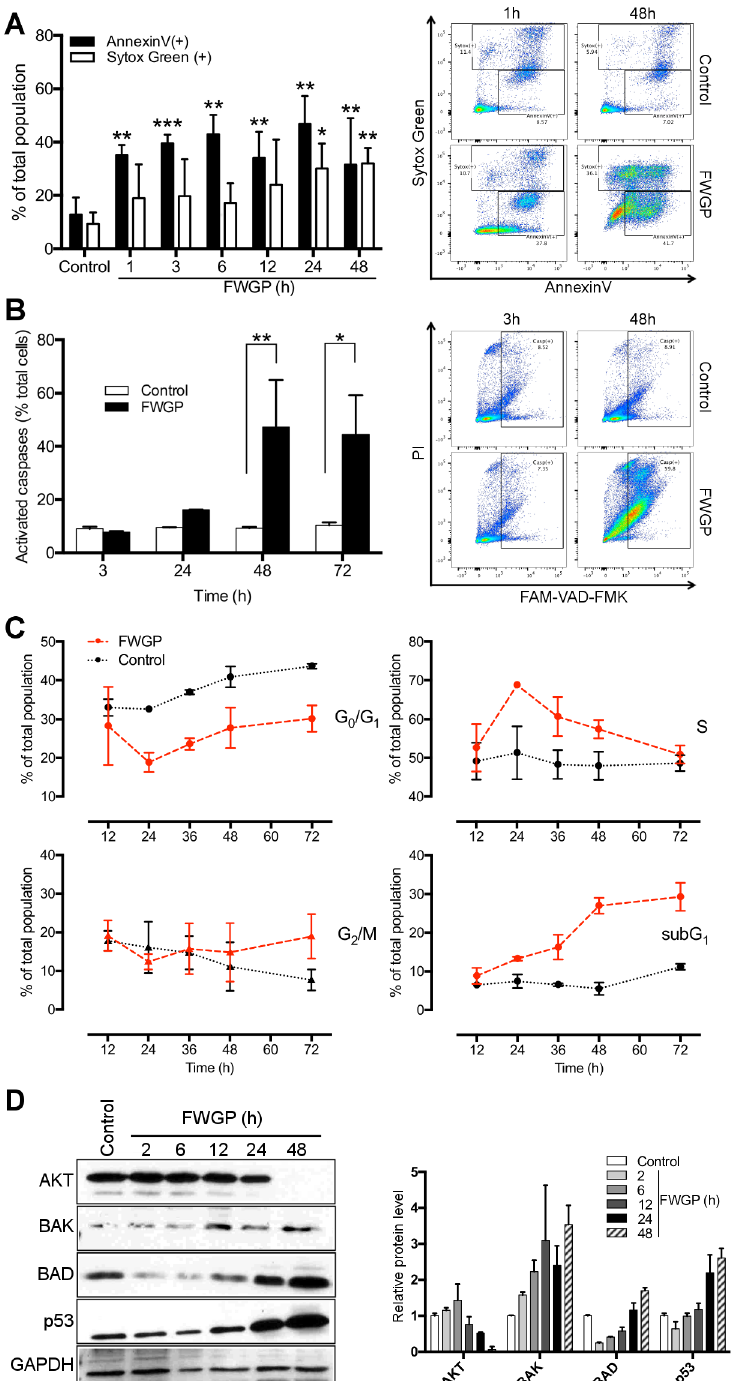
Fig 2. Effect of FWGP on apoptosis and cell cycle. (A) Early apoptosiswas measuredon Raji cells by flow cytometry after Annexin-V staining;Sytox Green was used for staining of late apoptotic/necrotic cells. Cells were incubatedwith FWGP (200 μ g/ml) for the indicatedtimes and compared to untreatedcontrols. (B) Flow cytometric detectionof activated caspases1, 2, 4, 5, 6, 8 and 9 using FAM-VAD-FMK substrate; propidium iodide(PI) was used as a counterstain. Bars represent mean ± SD (n = 3, * p < 0.05; ** p < 0.01; *** p < 0.001). Representative flow cytometry plots on the right. (C) Cell cycle analysisof Raji cells treated with FWGP. DNA content was measuredusing PI stainingof fixed cells. Cycle phasepopulationswere calculatedusing a